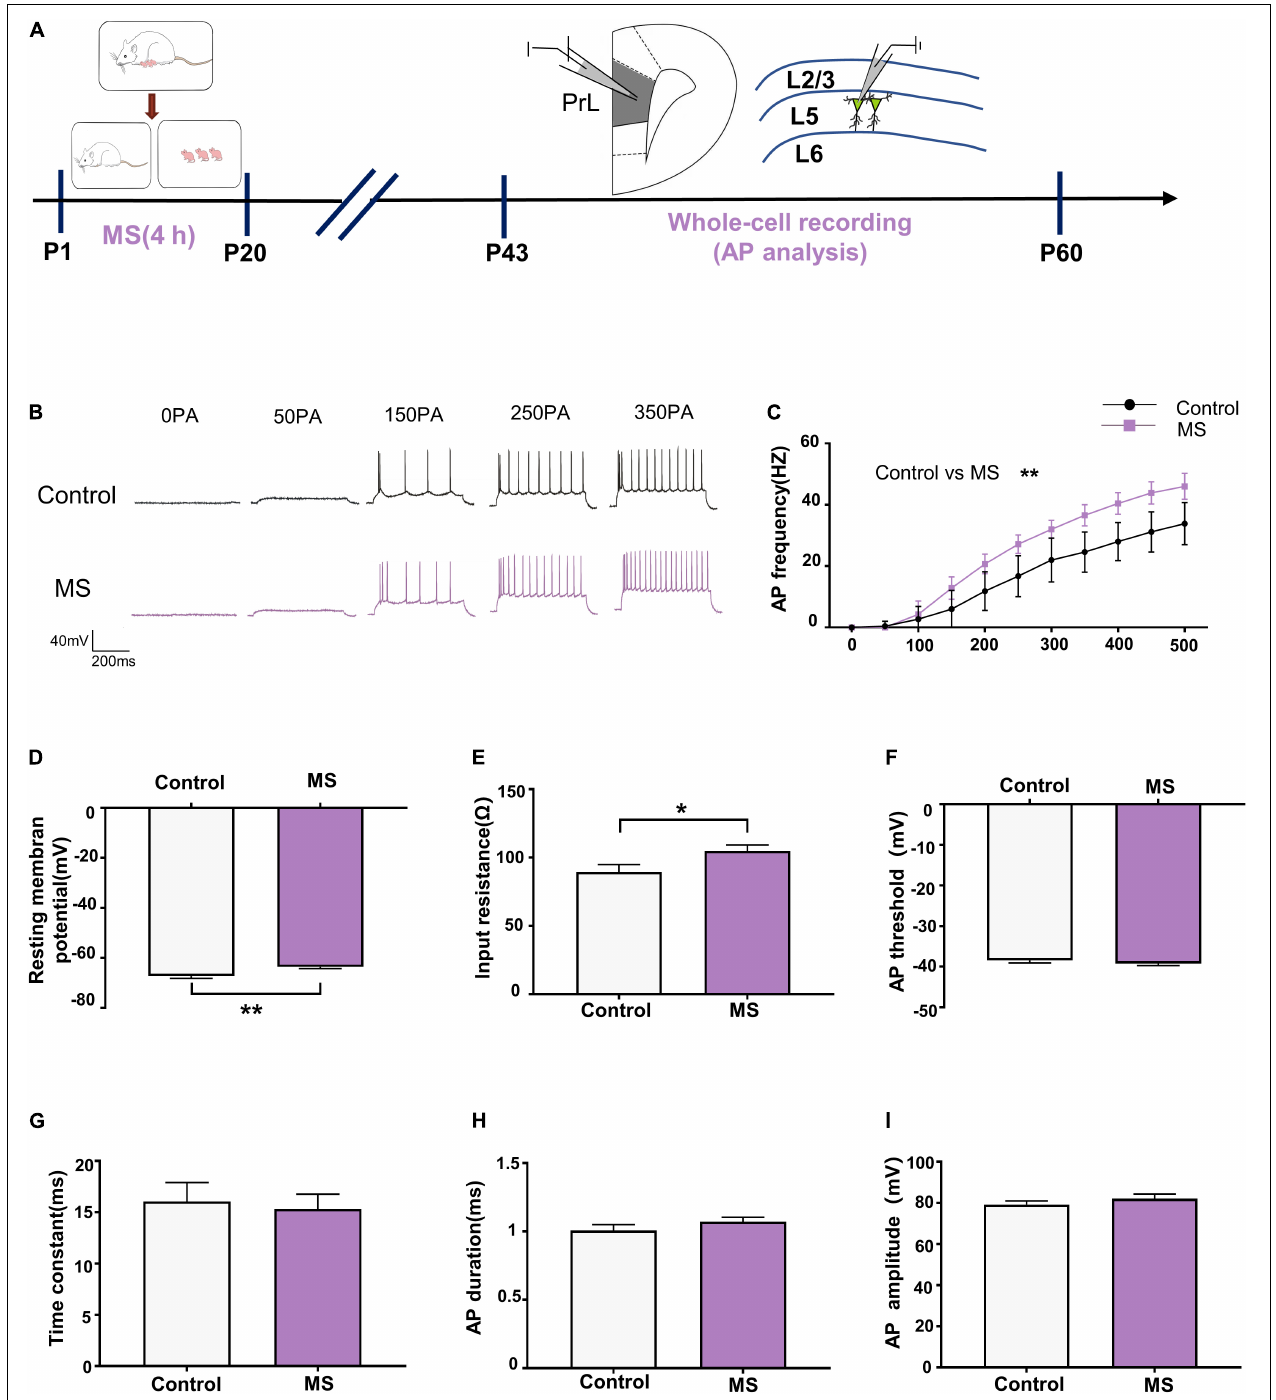
FIGURE 2 | Maternal separation induces an increase in neuronal excitability in L5 pyramidal cells in adolescence. (A) The experimental timeline of MS, whole-cell recording (AP analysis). (B) Representative trace of AP from the L5 pyramidal cell in PrL with current clamp under the condition of injecting incremental step currents of 0, +50, +150, +250, and +350 pA in control and MS at adolescent. Scale bars: 40 mV, 200 ms. (C) The frequency of action potential firing of pyramidal neurons in control and MS at adolescent. (D) The resting membrane potential of action potential of pyramidal neurons in control and MS at adolescent. (E) The input resistance of action potential of pyramidal neurons in control and MS at adolescent. (F) The threshold of action potential of pyramidal neurons in control and MS at adolescent. (G) The membrane time constant of action potential of pyramidal neurons in control and MS at adolescent. (H) The duration of the action potential measured at half-amplitude of pyramidal neurons in control and MS at adolescent. (I) The amplitude of action potential of pyramidal neurons in control and MS at adolescent. * p < 0.05, ** p < 0.01. Data are the means ± SEM ( n = 14 cells from 3 to 4 rats each group).